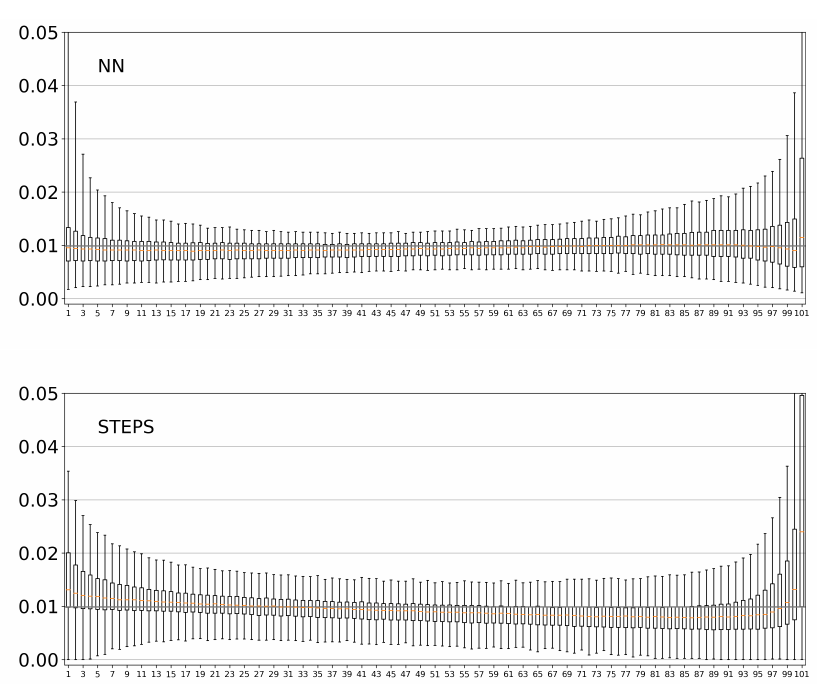
Figure 10. As for the previous figure for the cumulated precipitation in the first